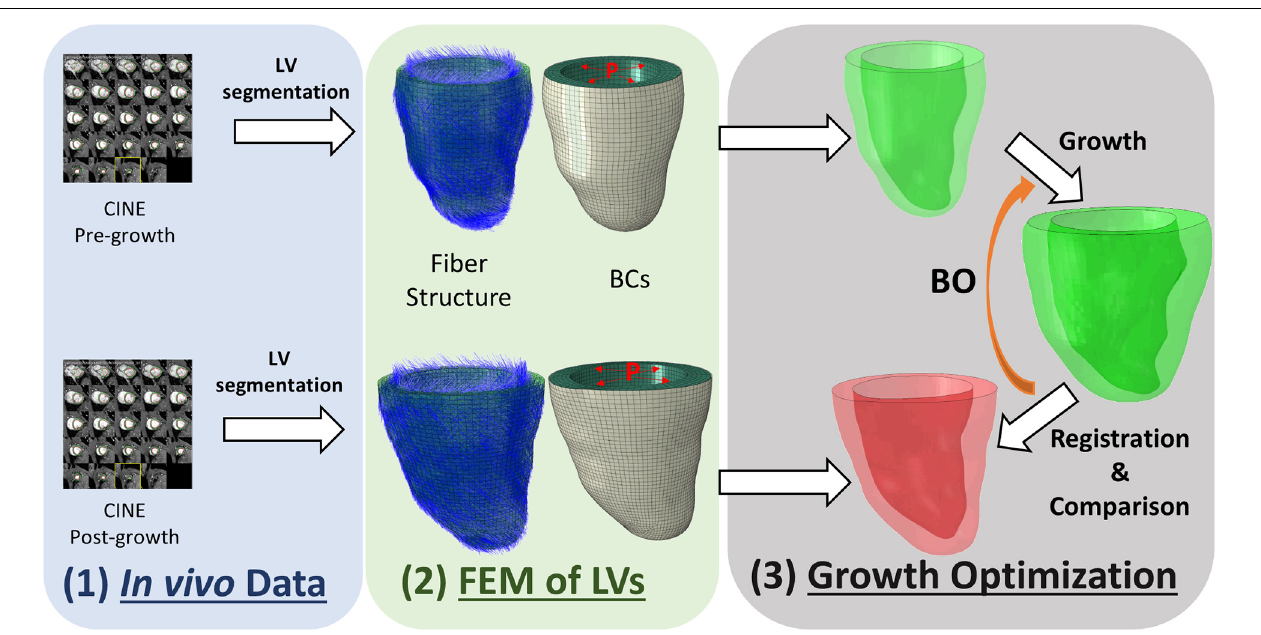
FIGURE 1 | Overview of the workflow used to characterize cardiomyocyte growth. The workflow contains three modules: (1) in vivo data collection, (2) building finite element model (FEM) of the pre-growth and post-growth LV geometries with idealized fiber orientation and boundary conditions (BCs) such as end-diastolic pressure and pericardium constraint, and (3) growth